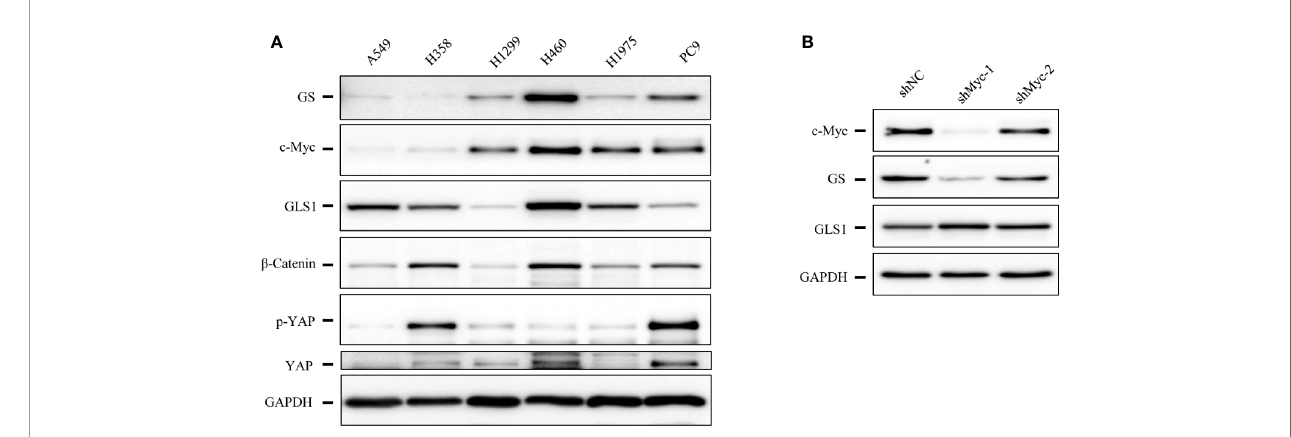
FIGURE 6 | The expression levels of glutamine synthetase (GS) were correlated with that of c-Myc in lung cancer cells. (A) Immunoblotting analysis of cell lysates of lung cancer cells. (B) Immunoblotting analysis of cell lysates of A549 cells expressing shcMyc and